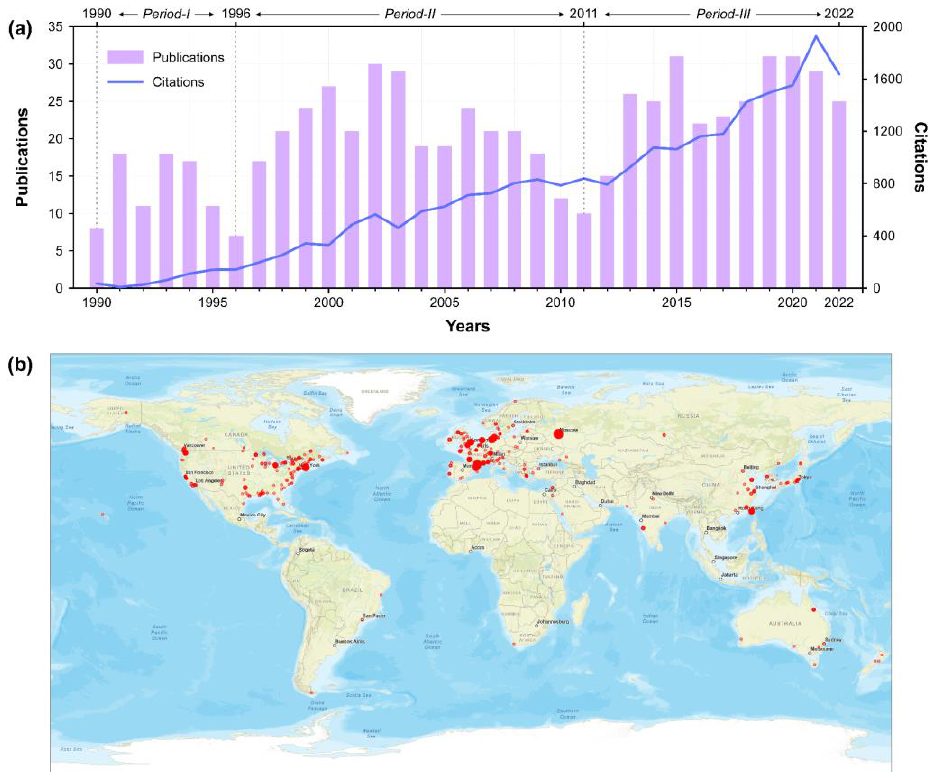
Figure 3. Spatiotemporal distribution of nepheloid layer research from 1990 to 2022. ( a ) Temporal trends of the annual number of publications and citations found in Web of Science Core Collection. ( b ) Geographical distributions of all institutions contributing to publications related to nepheloid layers. The size of the red circles reflects how many publications each institution has produced.